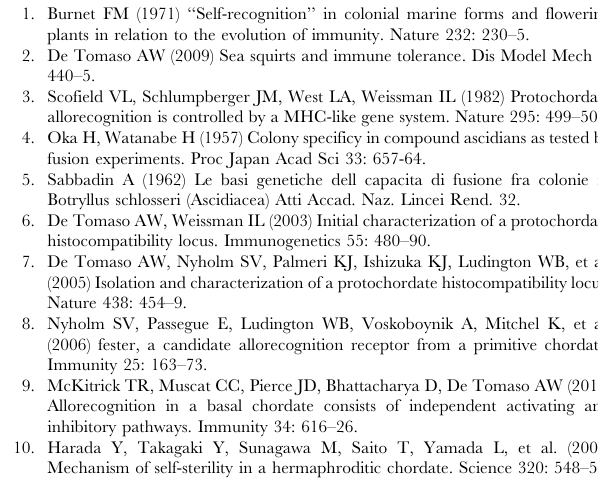
Figure S1 A. fuhc sec and fuhc tm cDNA and translated protein alleles from individuals used in Table 2 are shown. Primer sequences are included and described in the Methods. There is no concordance between the numbering of fuhc sec and fuhc tm alleles; i.e., no haplotype information is known. B. Sequence of the intergenic region between fuhc sec and fuhc tm